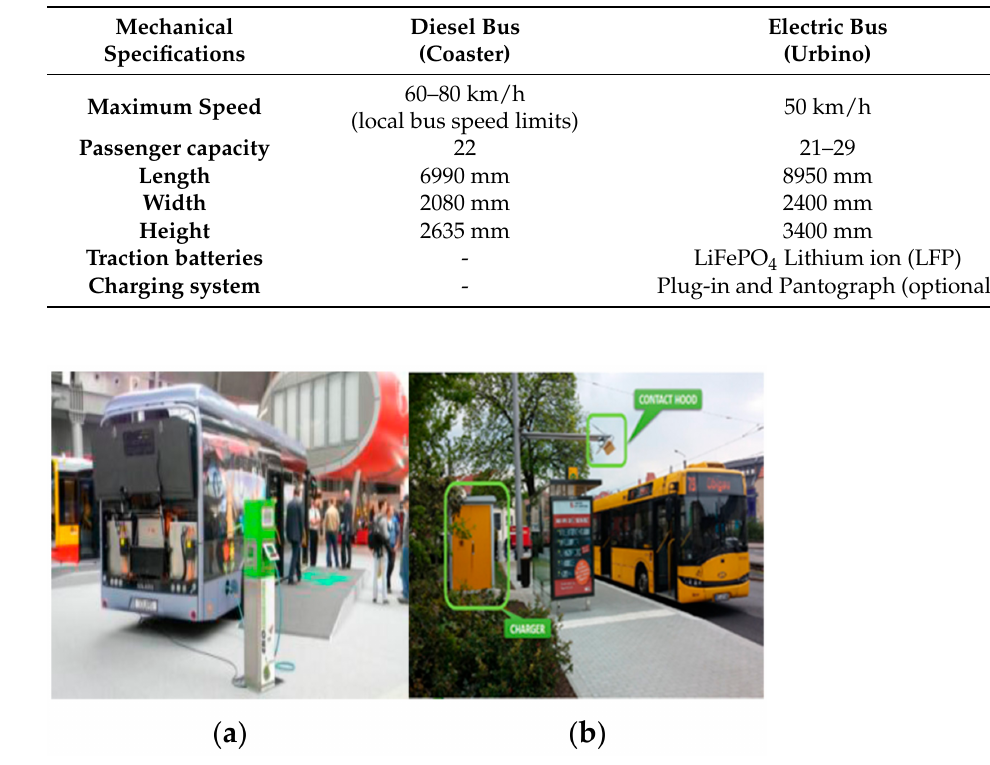
Figure 2. Illustration of ( a ) plug-in, and ( b ) pantograph chargers for electric